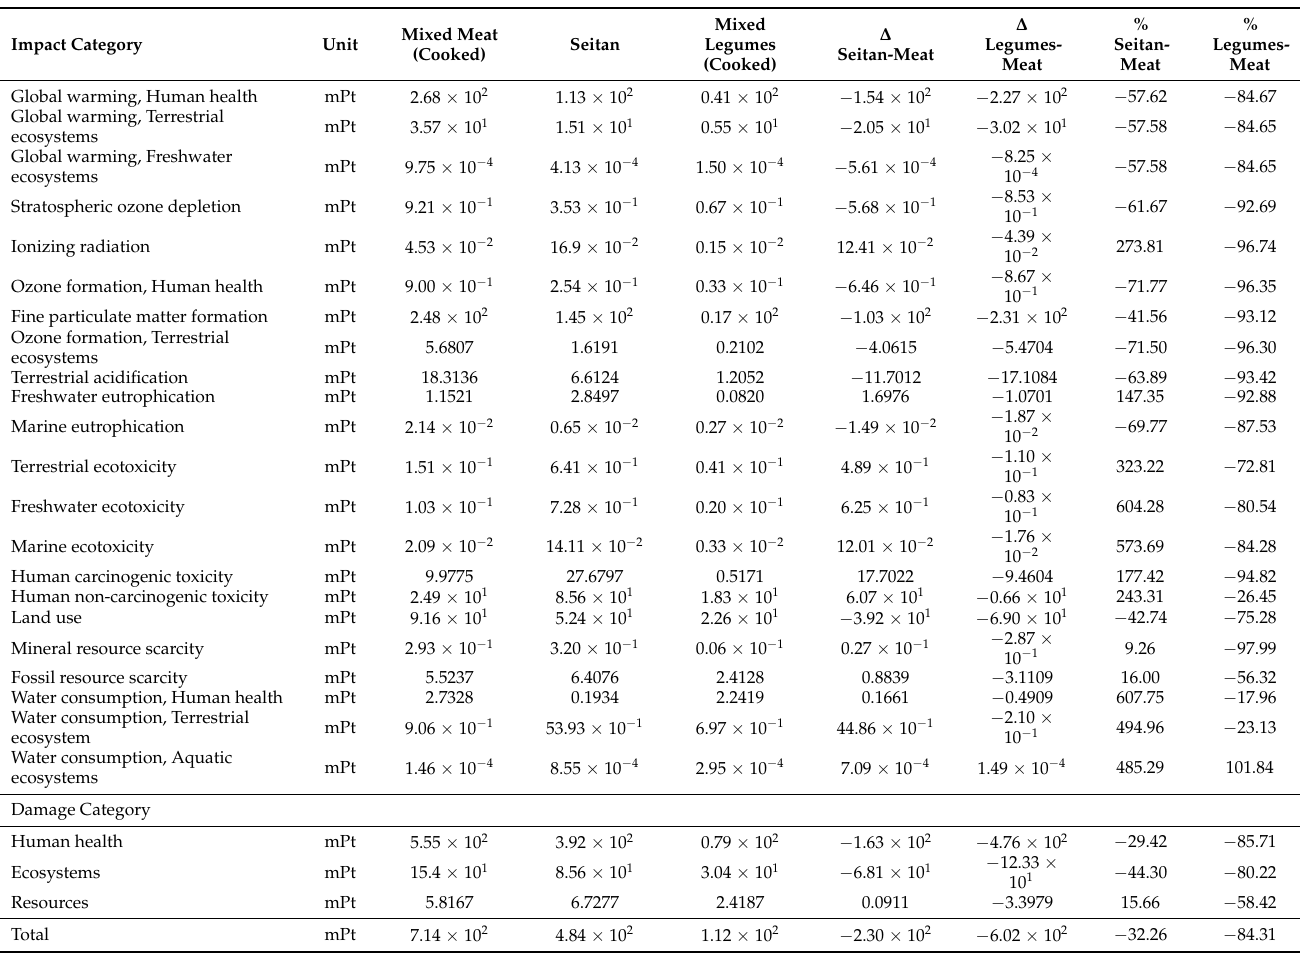
Table A5. Life Cycle Assessment Calculation (LCIA): comparison among Mixed Meat (cooked), Seitan and Mixed Legumes (cooked), proposed for steps. Impact Categories and Damage Categories. Aggre- gated Weighted Average: total environmental load expressed as a Single Score (mPt =